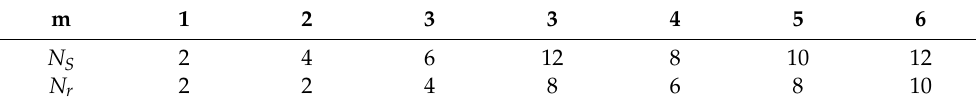
Table 1. Common pole slot fit combination of the stator and rotor of SRM.